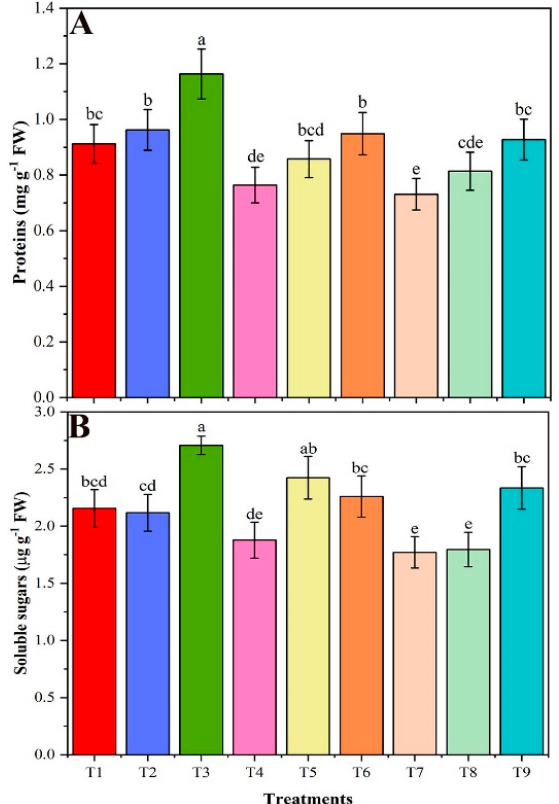
Figure 3. The total protein ( A ) and soluble sugars ( B ) contents of un-amended and amended soybean plants with chitosan modified and as-is biochar under saline conditions. Data are shown as the mean ± standard deviation (n = 3). Di ff erent letters above the chart columns indicate significant di ff erences among treatments ( p ≤